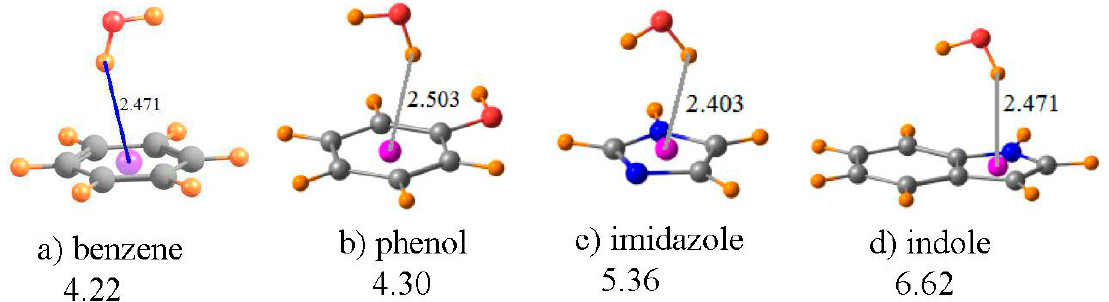
Figure 5. Optimized geometries of HOH situated above the planes of the indicated aromatic molecules. Purple sphere represents center of each ring. Numbers under the compound names refer to interaction energy in kcal/mol. Distances are in Å. Table 4. NMR isotropic shielding (ppm) of OH·· π complexes shown in Figure 5, along with density at bond critical points ( ρ BCP ) in 10 − 3 au, and interaction energy ( −∆ E) .